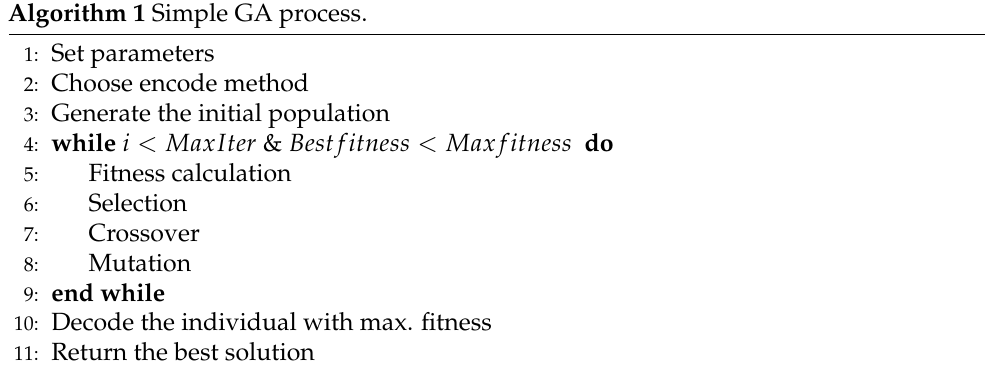
Algorithm 1 Simple GA